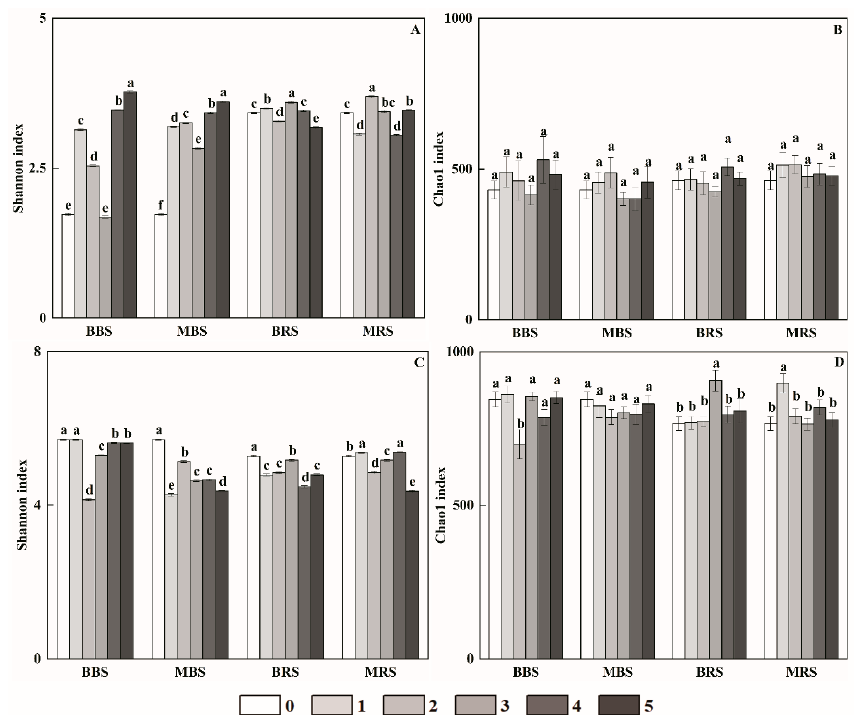
Figure 2. Diversity indices calculated from gene sequencing data based on the operational taxonomic unit (OTU). ( A ) Fungal Shannon index. ( B ) Fungal Chao1 index. ( C ) Bacterial Shannon index. ( D ) Bacterial Chao1 index. B and M indicate bamboo biochar and bacteria-inoculated biochar; BS and RS indicate bulk soil and rhizosphere soil. 0, 1, 2, 3, 4, and 5 indicate control, 2.22 t · ha − 1 , 4.44 t · ha − 1 , 6.67 t · ha − 1 , 8.89 t · ha − 1 , and 11.11 t · ha − 1 . Small letter superscripts depict significance ( p < 0.05) in the pairwise Tukey’s HSD test. Error bars represent the standard deviation from the mean ( n =